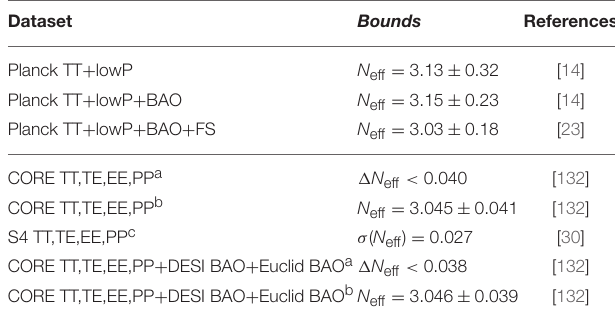
TABLE 4 | Constraints on N eff (at 68% CL) from different combinations of cosmological data.